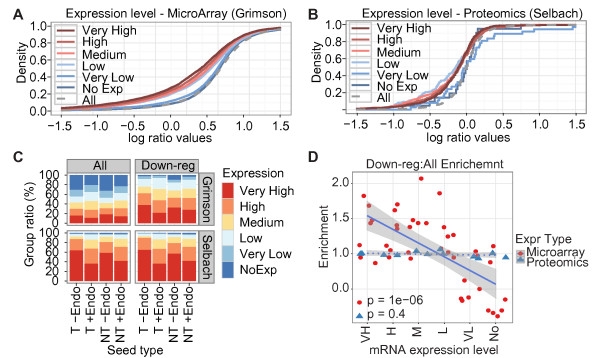
Microarrays but not proteomics are biased towards detecting differential expression among highly expressed genes. Cumulative density plots of log-ratio values for miRNA targets grouped by gene expression levels in (A) the Grimson and (B) the Selbach datasets. (C) Barplots show the ratio of the six sub-groups of mRNA expression levels subdivided by predicted exogenous and endogenous miRNA targeting in the Grimson and Selbach datasets for all genes ('All') and down-regulated genes ('Down-reg' P < 0.01; log ratio (lr) < -0.01). (D) Scatter plots show log2 enrichment of down-regulated genes compared with all genes for the six sub-groups of mRNA expression levels in all studied datasets. Lines and shaded grays show respectively linear fits and standard errors for the microarray (red dots) and proteomics (blue triangles) experiments; P-values (lower left) are unadjusted P-values from Pearson correlation tests. Data points based on a single gene were excluded. The regression lines show that in the microarray but not the proteomics experiments, down-regulated genes are enriched among highly expressed genes and that this enrichment depends on gene expression levels. miRNA, microRNA; mRNA, messenger RNA.